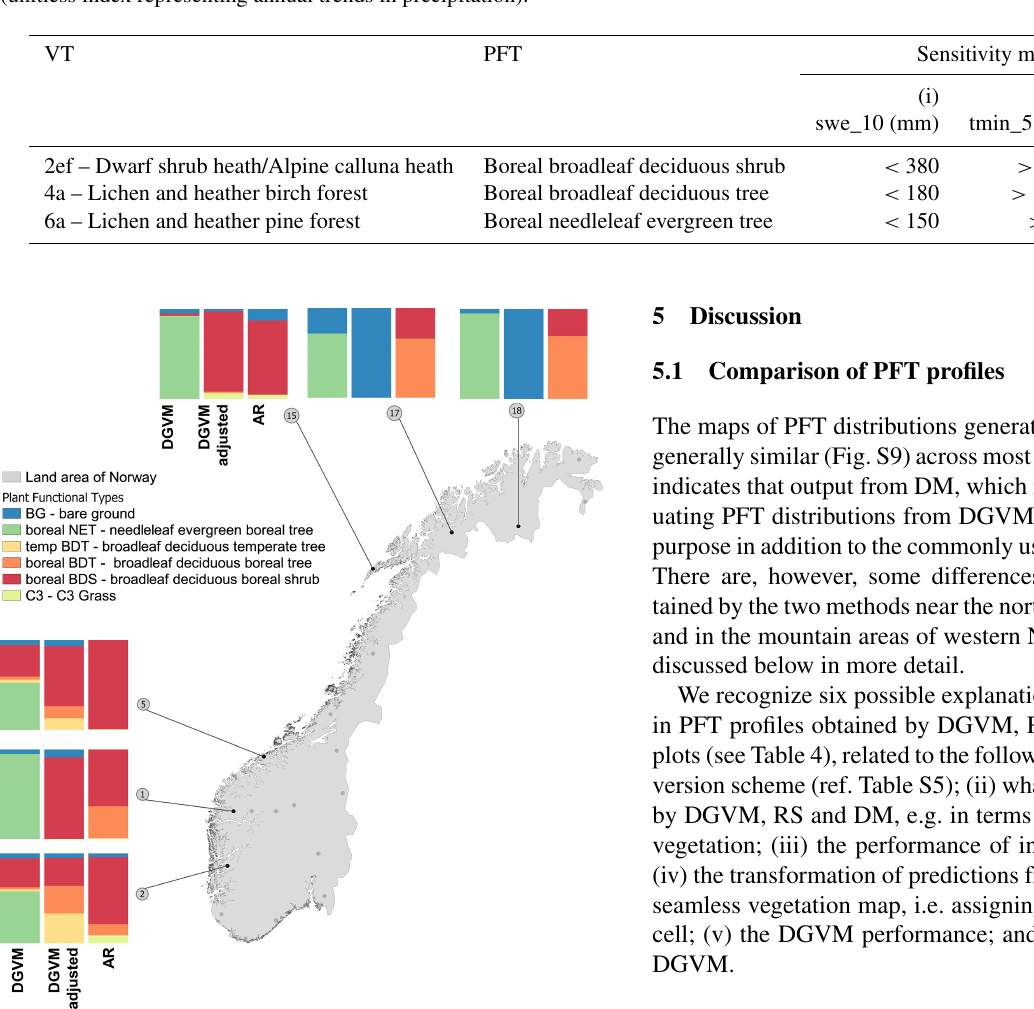
Table 3. New thresholds for establishment of the three PFTs explored in DGVM sensitivity experiments. The variables explored were swe_10 – snow water equivalent in October given in mm, tmin_5 – minimum temperature in May ( ◦ C) and bioclim_15 – precipitation seasonality (unitless index representing annual trends in precipitation).